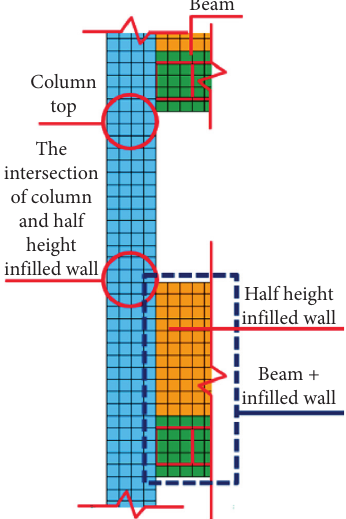
Figure 52: Initial state of second-floor side column.